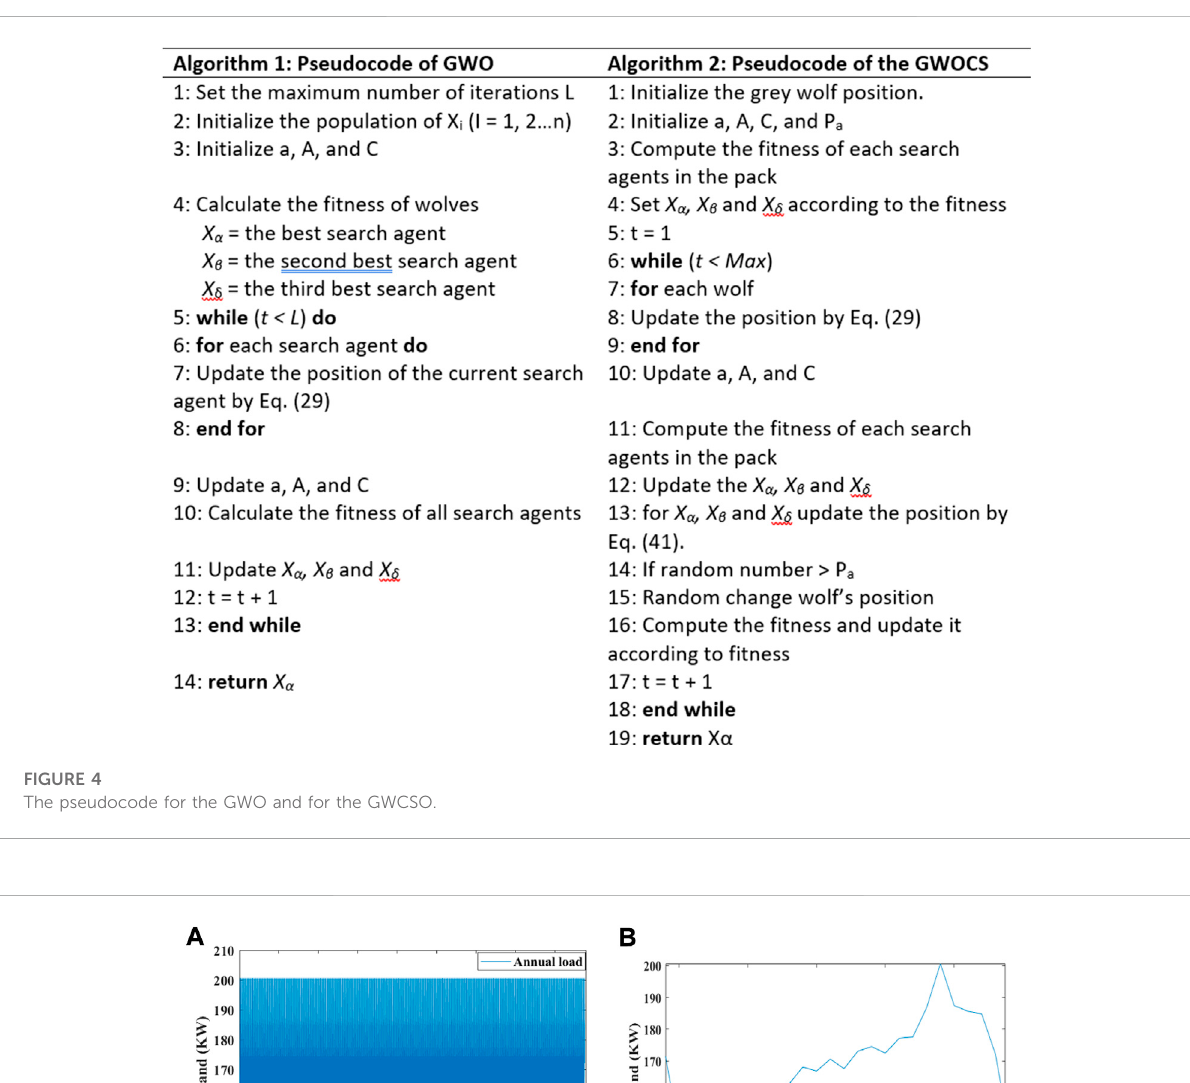
FIGURE 5 The adopted (A) annual load and (B) daily